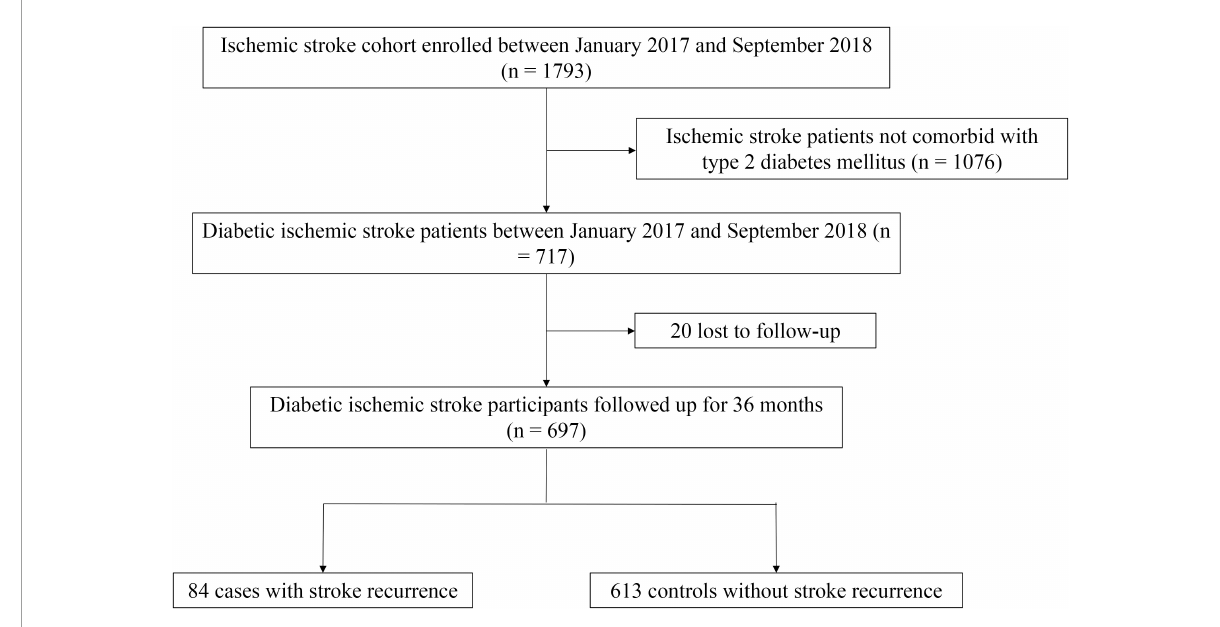
FIGURE1 Flow chart for study participant